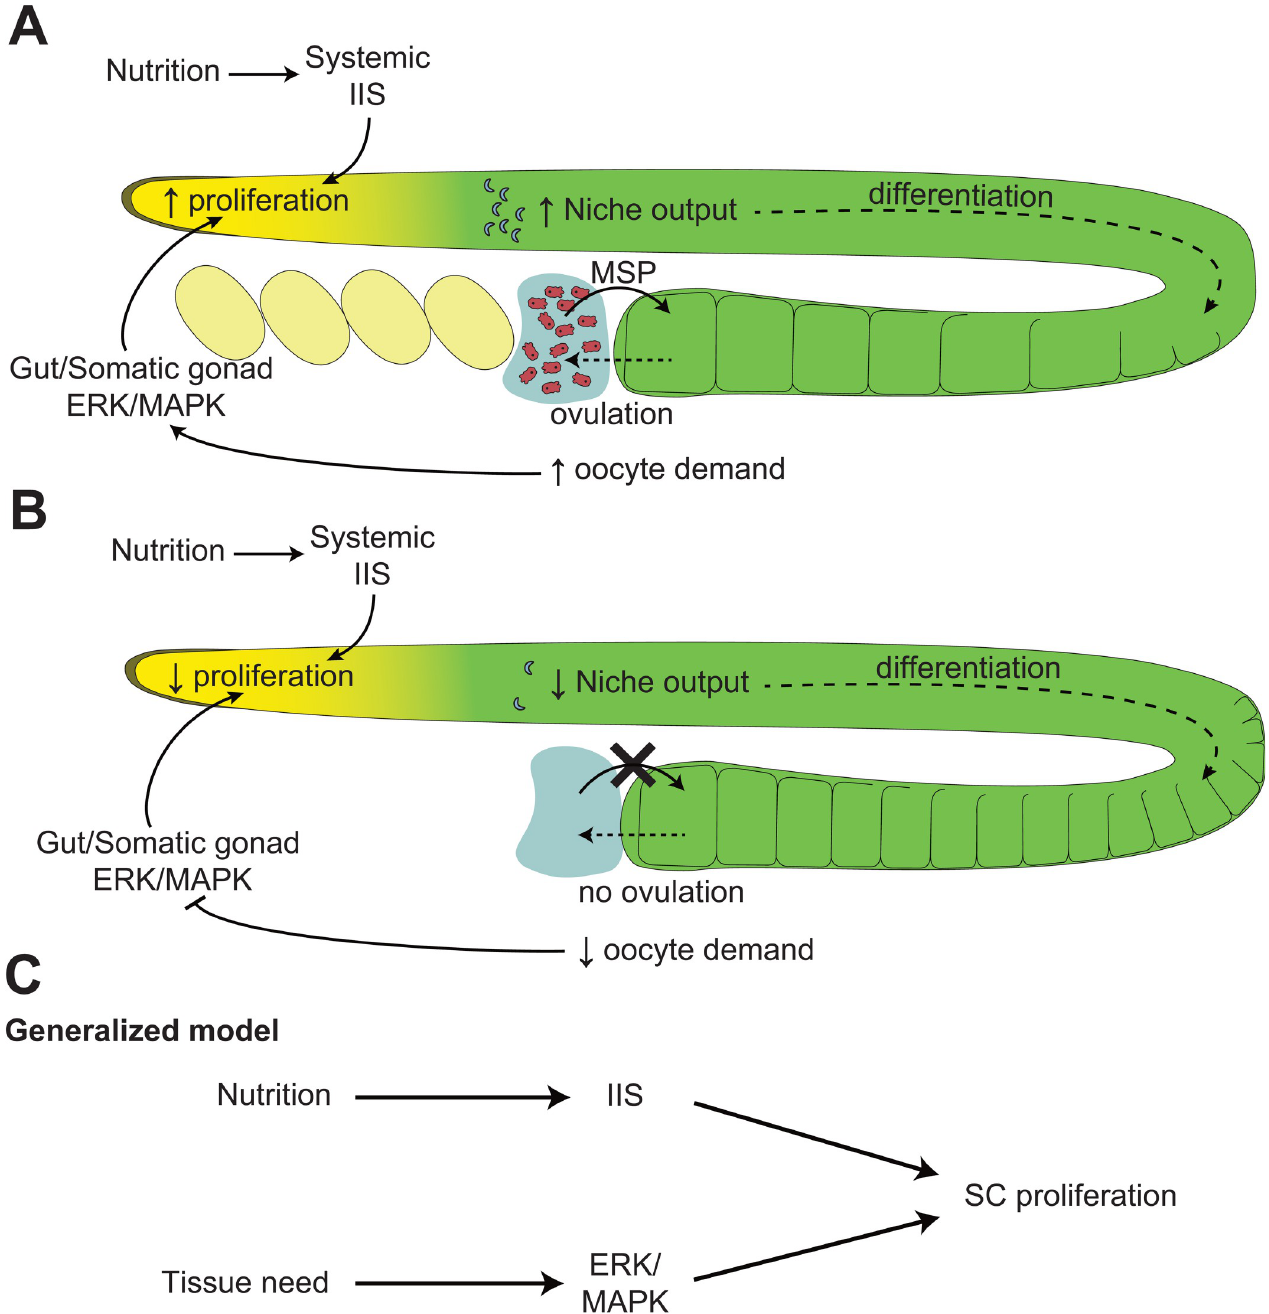
Fig 2. SC proliferation regulatory mechanisms. (A) Schematic representation of the 2 known mechanisms that regulate GSC proliferation in young adult C . elegans hermaphrodites. The nutritional status systemically regulates GSC proliferation through activating IIS. In this case, the insulin receptor DAF-2 and its main downstream transcriptional target DAF-16/FOXO both act within the germline to influence GSC proliferation [33,35].In parallel, the presence of sperm, through release of MSPs, promotes oocyte ovulation, maintaining a high oocyte demand. This presumably activates MPK-1/ERK in the animal’s gut and/or somatic gonad, which nonautonomously promotes GSC proliferation, and sustains an elevated niche output and oocyte production [41]. (B) When sperm is depleted, ovulation is suppressed and oocytes initially accumulate in the proximal gonad, thereby reducing the demand for new oocytes. This is expected to suppress MPK-1/ERK signaling in the gut and/or somatic gonad, thereby slowing down GSC proliferation and oocyte production. (C) A generalized model for the regulation of SC proliferation by nutrition and tissue demand. Note that while the function of IIS thus far appears well conserved [18], ERK/MAPK signaling could be replaced by other pathways in different SC types or organisms. Additional regulatory mechanisms may also exist. GSC, germline stem cell; IIS, insulin-like/IGF-1 signaling; MSP, major sperm protein; SC, stem cell.